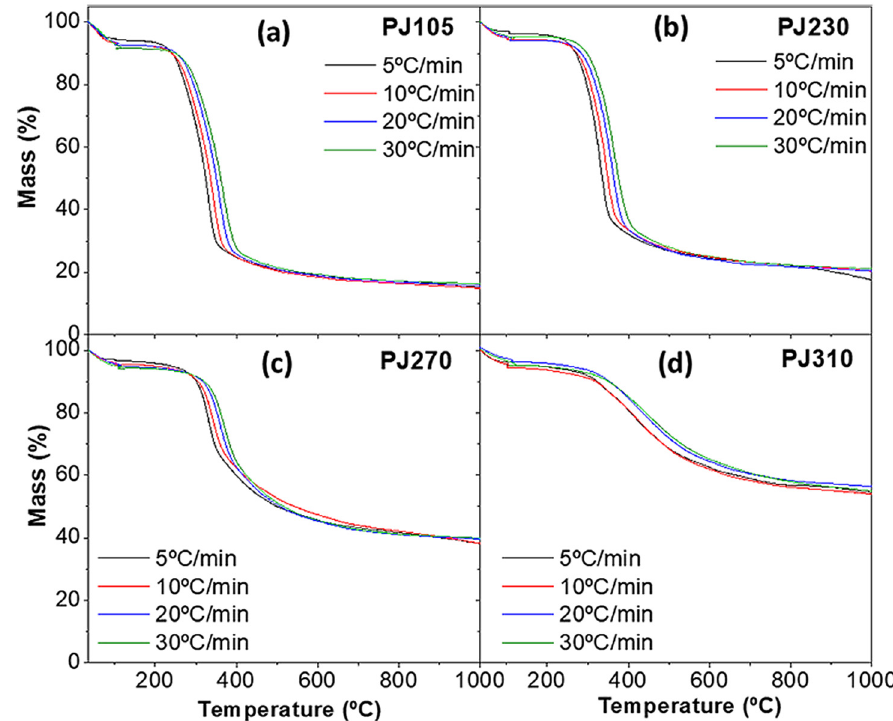
Figure 6. TG profiles of P. juliflora samples at different heating rates of 5, 10, 20, and 30 °C/min for ( a ) raw biomass—PJ105; ( b ) PJ230; ( c ) PJ270; ( d ) PJ310. Table 4. Devolatilization percentages of P. juliflora